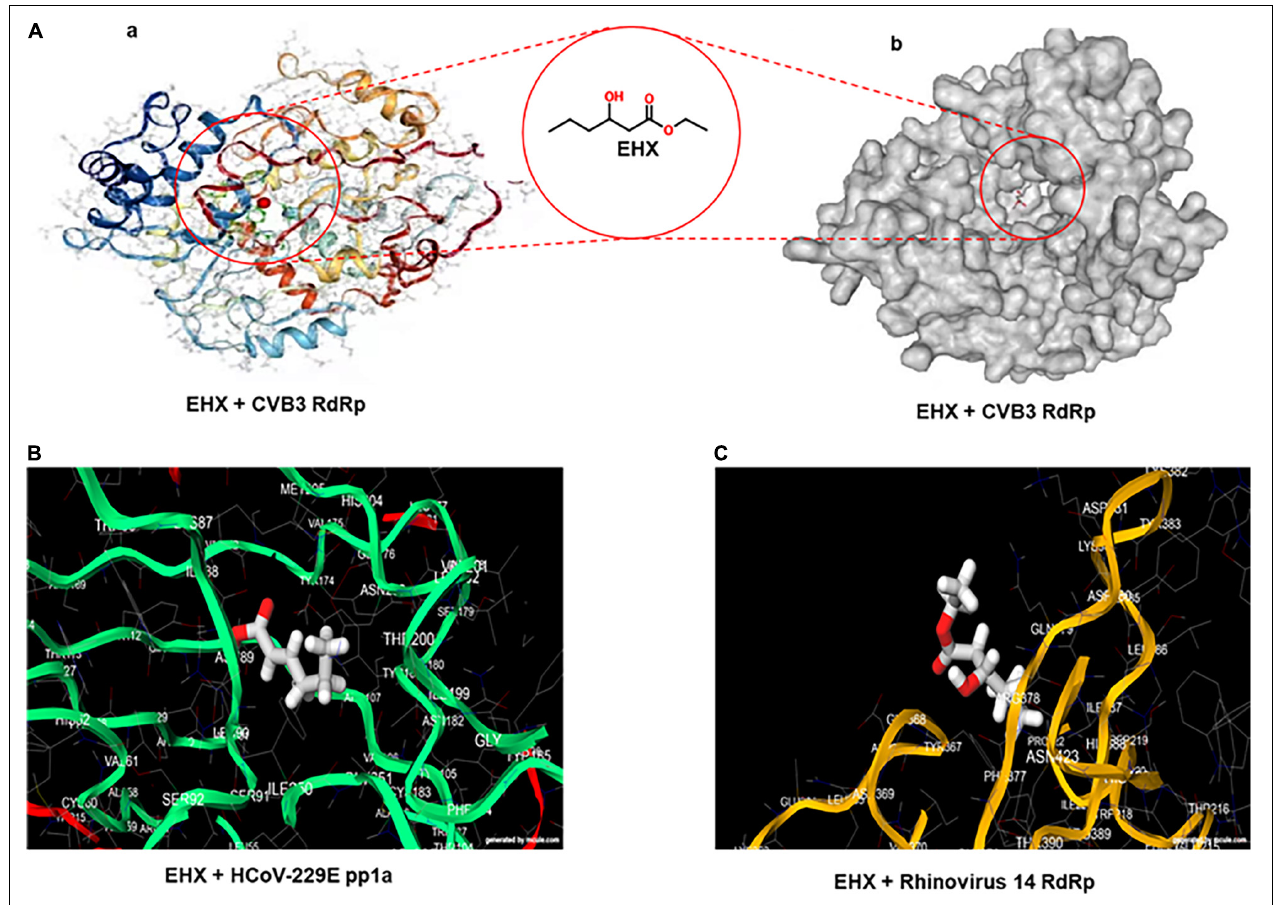
FIGURE 4 | Viral non-structural protein is the potential target of EHX. (A) Three-dimensional structure of CVB RdRp showing the predicted binding site of EHX. The structures of the CVB RdRp were retrieved from the PDB (ascension number: 3DDK). Images were generated using the MedusaDock online software. (B,C) The predicted binding site of EHX with putative structure of human coronavirus-229E replicase polyprotein 1a and rhinovirus 14 RdRP. Images were generated on www.mcule.com/apps/1-click-docking/. HCoV-229E, human coronavirus-229E; pp1a, polyprotein 1a; RdRP, RNA-dependent RNA